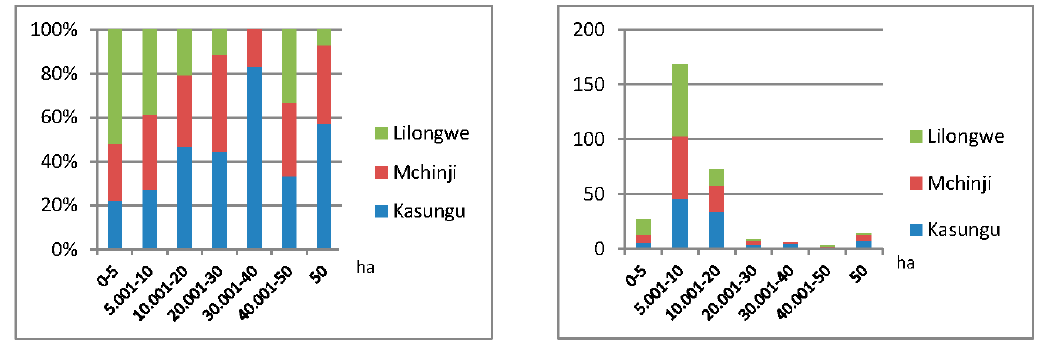
Figure 2. Numbers of medium-scale farmers sampled, per size category and per district, proportionally per size category and in absolute numbers per size category ( N = 300). Source: Authors’ medium-scale farm survey in the Mchinji, Kasungu and Lilongwe Districts undertaken by LUANAR, UP, and MSU (2014–2015). Note: There is a statistically significant difference in size categories between Lilongwe, Mchinji and Kasungu (Anova p -value 2.90 × 10 −41 ).